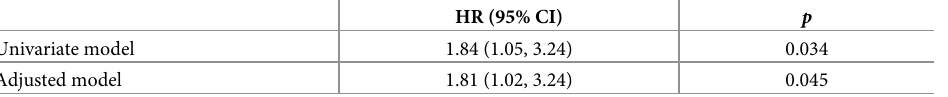
Table 3. Association of low Zn levels with the primary outcome in the propensity score-matched